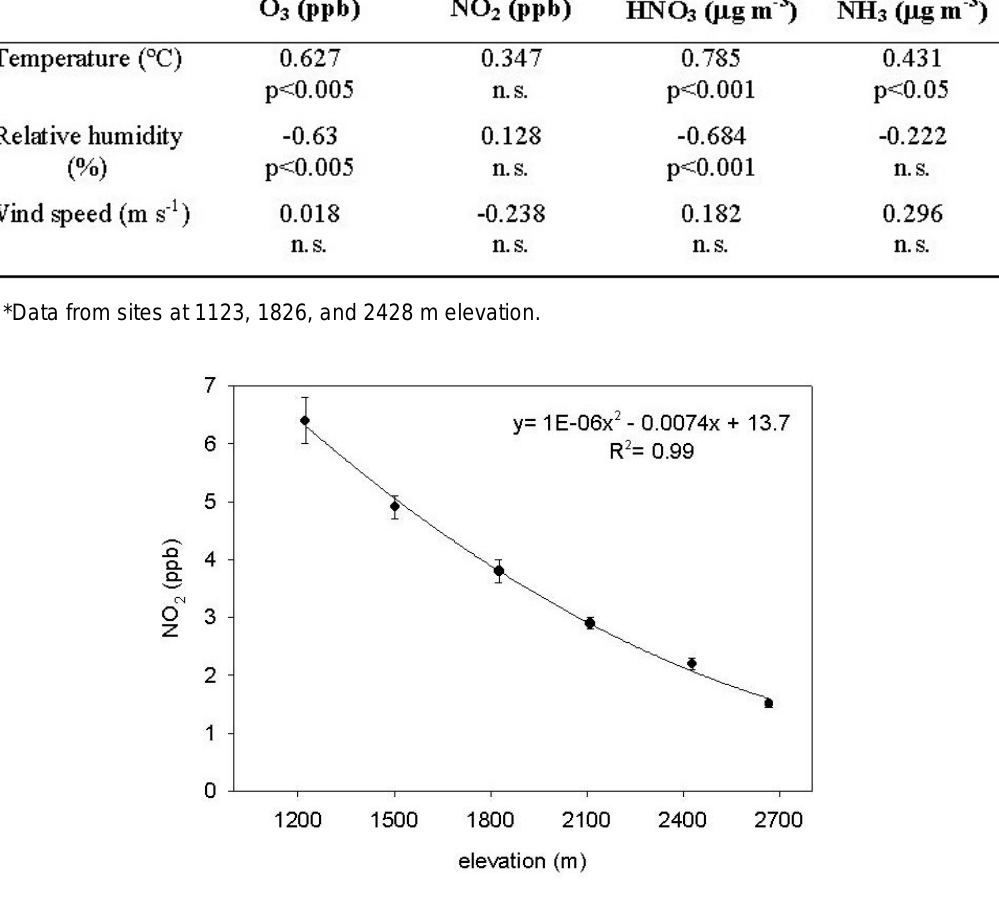
all the sites along the gradient were around 1 to 2 ppb that is within the measurement uncertainty of these